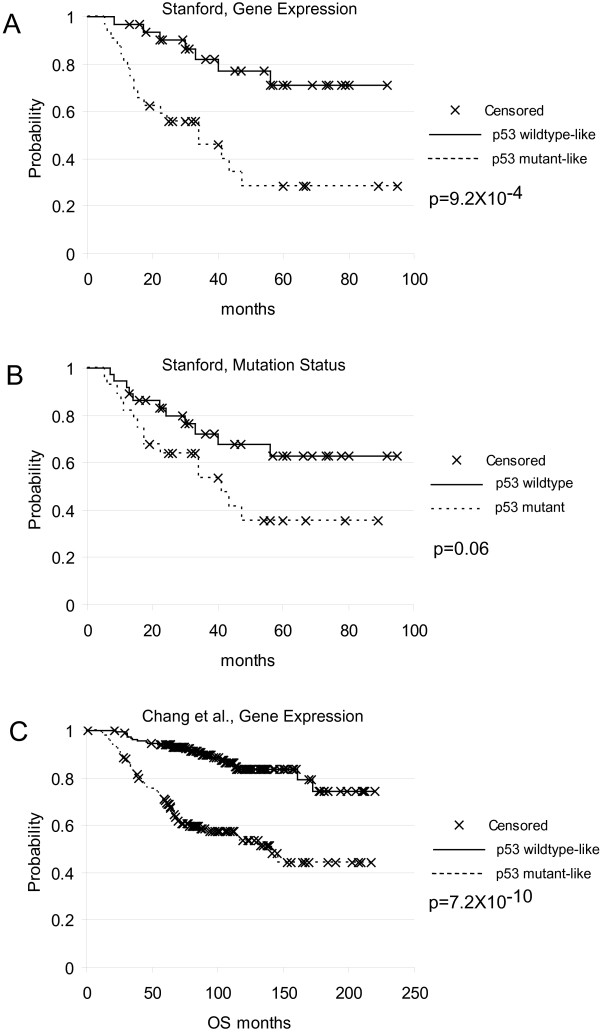
Kaplan-Meier survival curves for patients with p53 wildtype (solid line) or mutant (dashed line) tumors using gene expression-based p53 functional category or mutation status. Overall survival analysis comparing the two gene-expression based dendrogram groups (tumors in Figure 5A vs. tumors in Figure 5B) yielded a highly significant difference in survival, which compares favorably with mutation status. Both analyses used 66 tumor samples and included 26 events. Survival analysis on a separate data set (Chang et al., 2005) including 337 tumors and 79 events (C) also yielded highly significant differences based on gene expression classification.